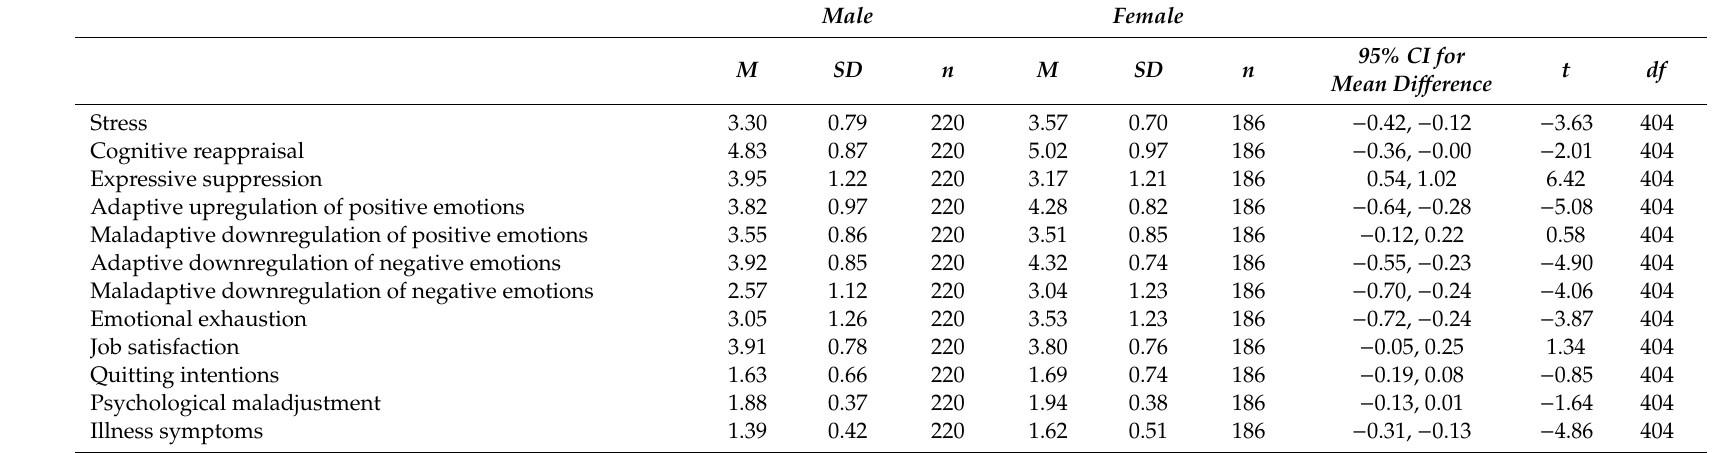
Table 3. Gender Di ff erences in Emotion Regulation Strategies, Stress, and